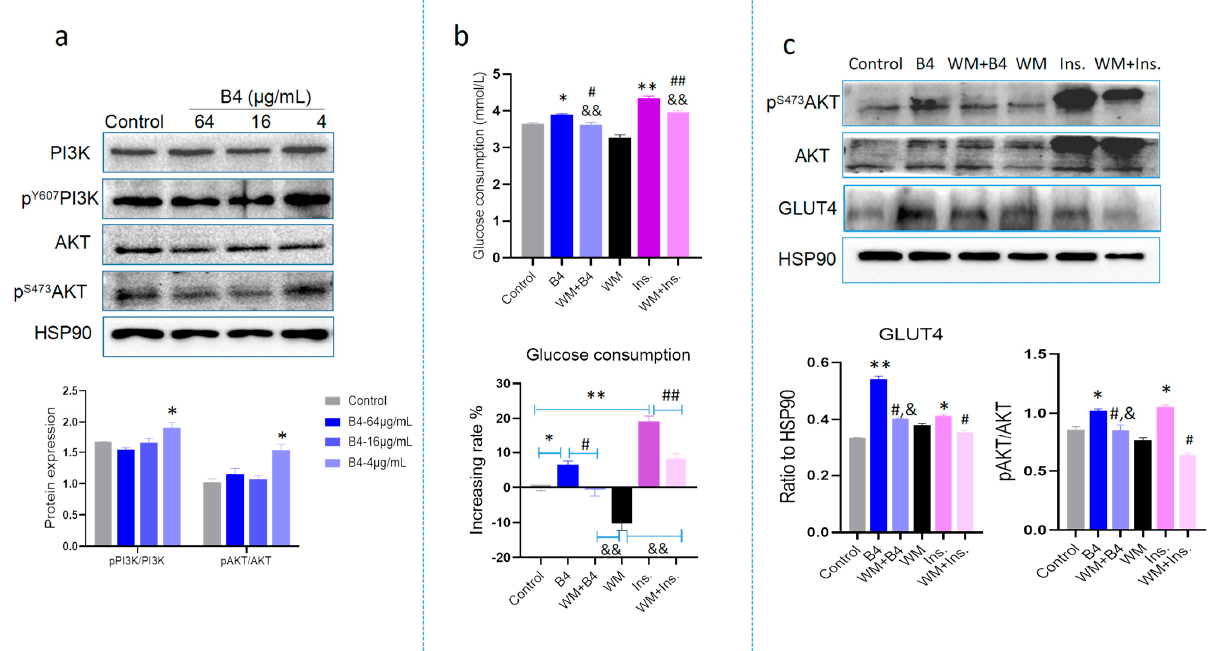
Figure 6. Protein expression and glucose consumption in the presence of B4 treated with the inhibitors or both in L6 cells. ( a ) The protein expression of PI3K/AKT in L6 cells; ( b ) Glucose consumption; ( c ) Western blot assay detected expression of the downstream protein of PI3K. * p < 0.05, ** p < 0.01 vs. control group; # p < 0.05, ## p < 0.01 vs. B4 or Ins. group; & p < 0.05, && p < 0.01 vs. WM group. Data represent the mean ± standard error of three separate experiments. Ins: inslin, WM: wortmannin.